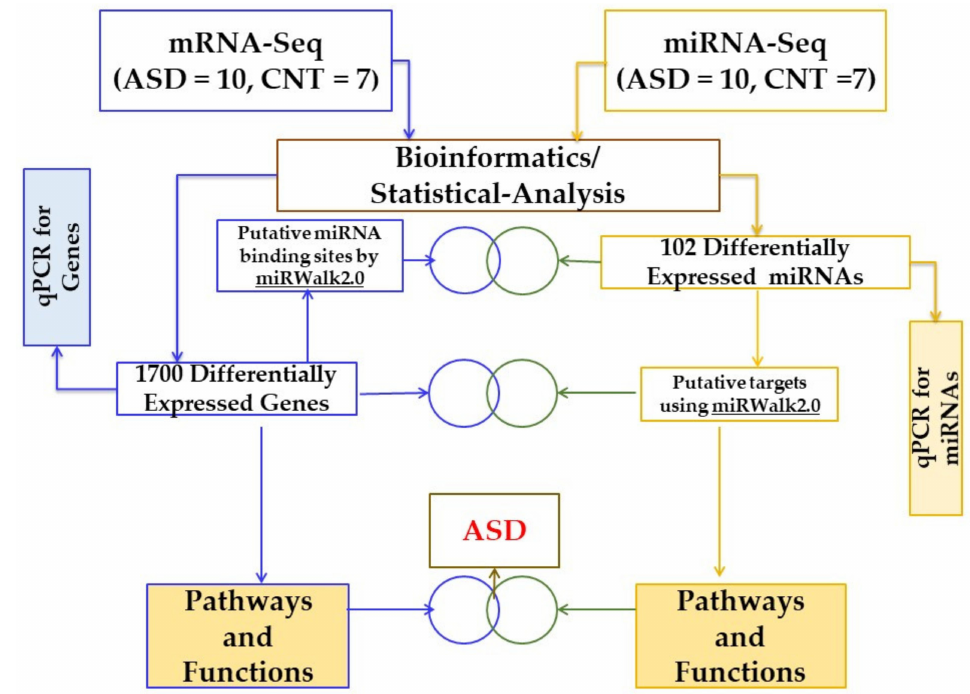
Figure 1. Schematic workflow to study differentially regulated genes, miRNAs, and pathways in ASD and CNT LCLs. ASD = autism, CNT = control, LCLs = lymphoblastoid cell